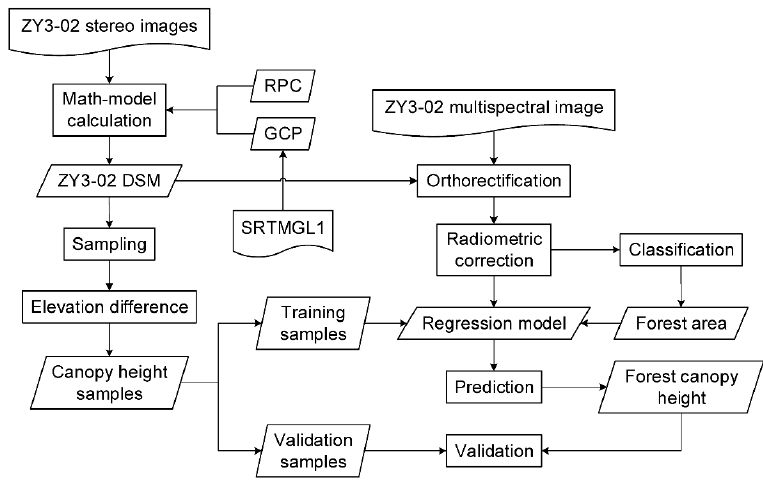
Figure 2. Flow chart of methods. Legend: RPC, rational polynomial coefficients; GCP, ground control point; DSM, digital surface model; SRTMGL1, Shuttle Radar Topography Mission global 1 arc second data.